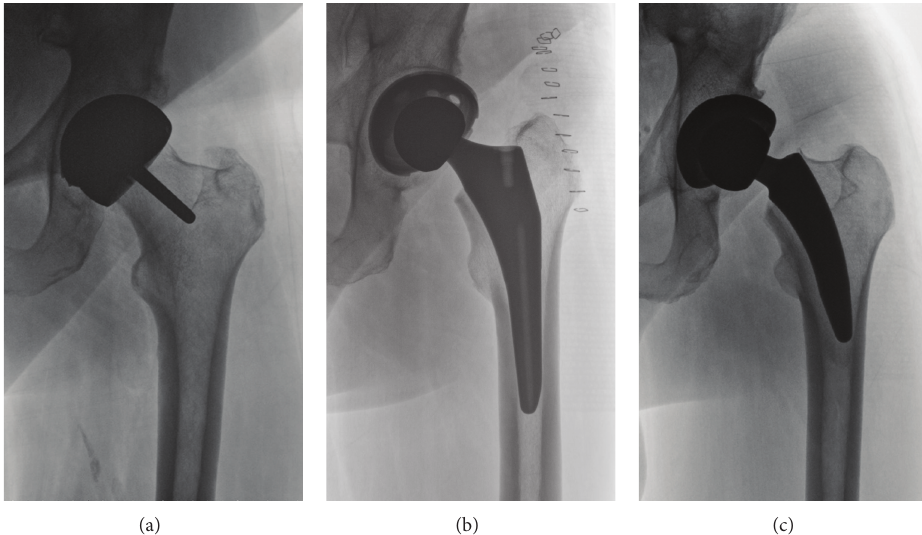
Figure 1: (a) HR implant, (b) traditional implant, and (c) neck-preserving, short-stem implant (Corin MiniHip). Most bone tissue is retained with HR (femoral head and neck, no significant intrusion of the femoral canal), whereas parts of the femoral neck are also preserved with the MiniHip